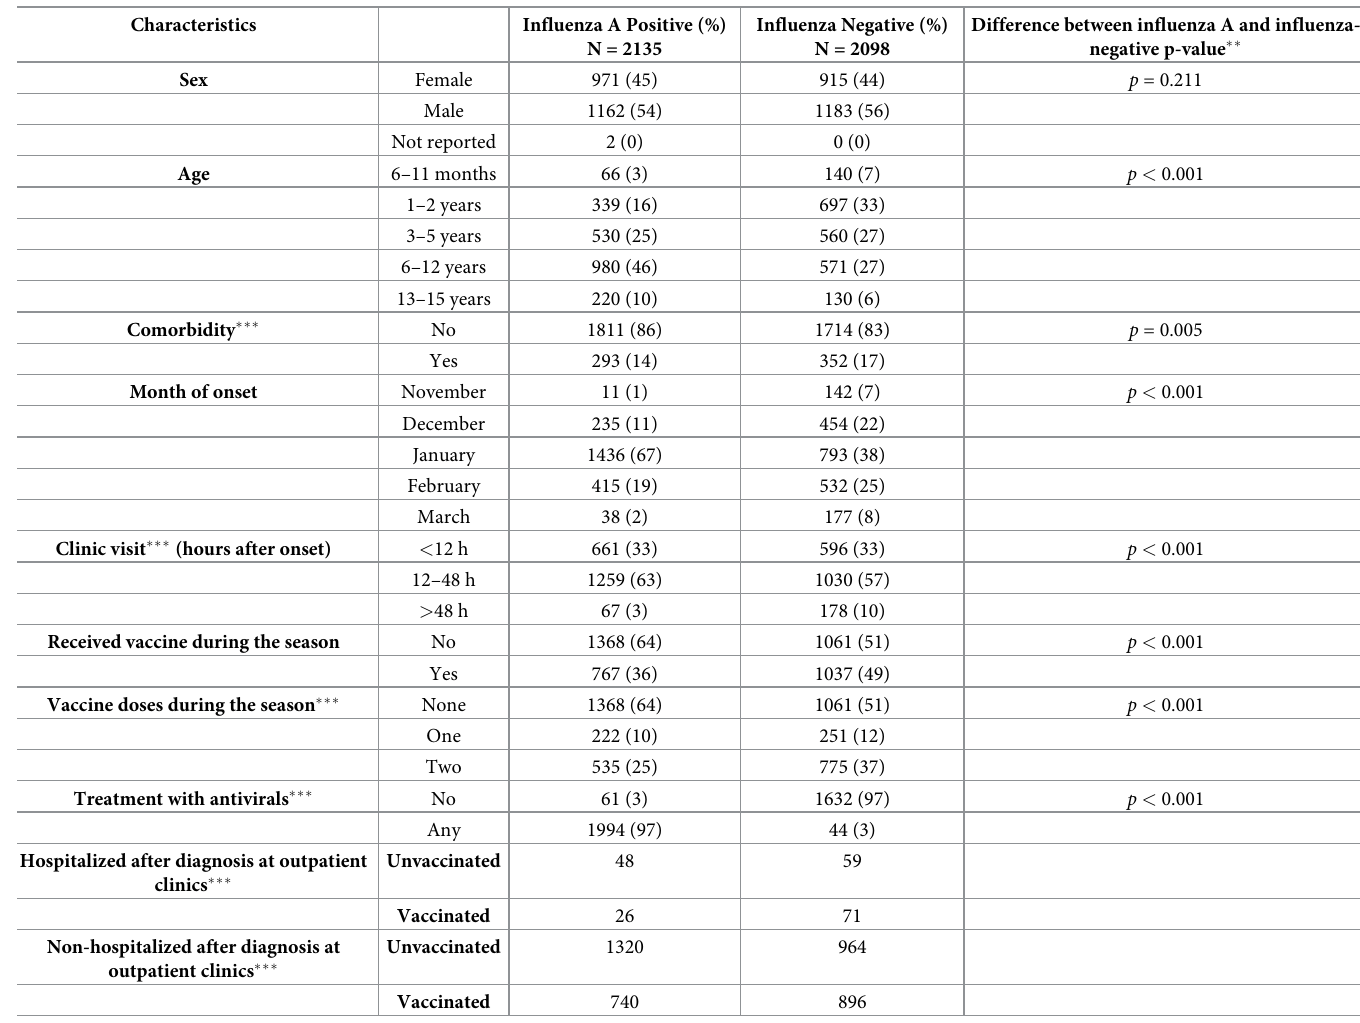
Table 1. Characteristics of children enrolled in 2018/19 season (n = 4243) �